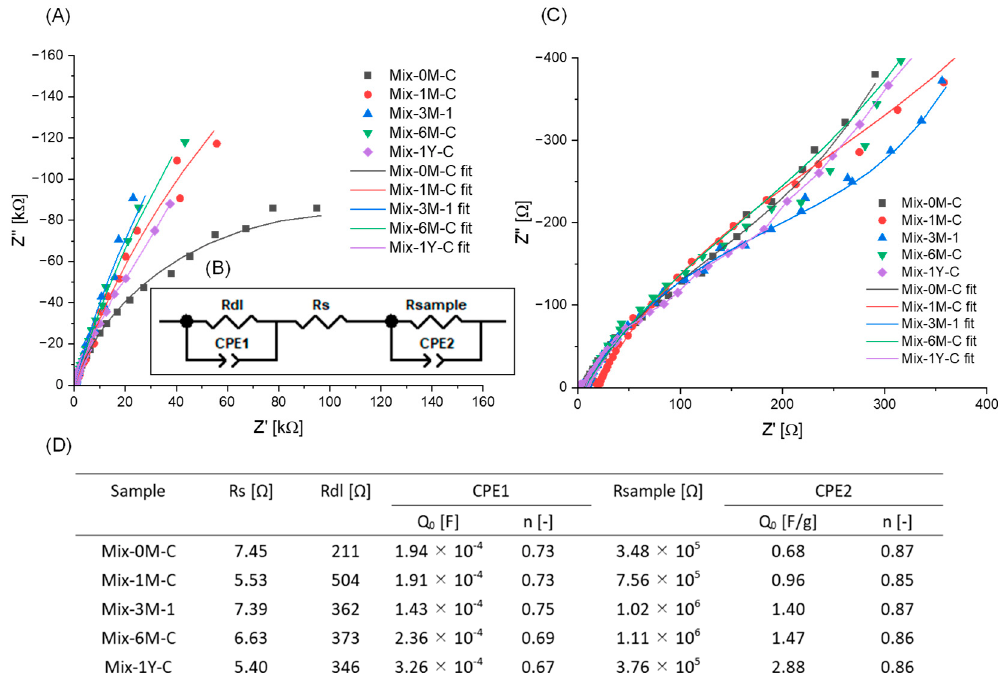
Figure 6. ( A ) Electrochemical impedance spectra (EIS) (Nyquist plots) and fitting curves of Mix-0M-C, Mix-1M-C, Mix-3M-1, Mix-6M-C, Mix-1Y-C. ( B ) Equivalent circuit model used for fitting the EIS data. Rdl: resistance of electrode double layer; CPE1: constant phase element for electrode double layer; Rs: resistance of the solution; Rsample: resistance of the sample; CPE2: constant phase element for sample; Q 0 and n are frequency-independent parameters of CPE. ( C ) Nyquist plots and fitting curves on high-frequency range. ( D ) Table of fitting parameters.